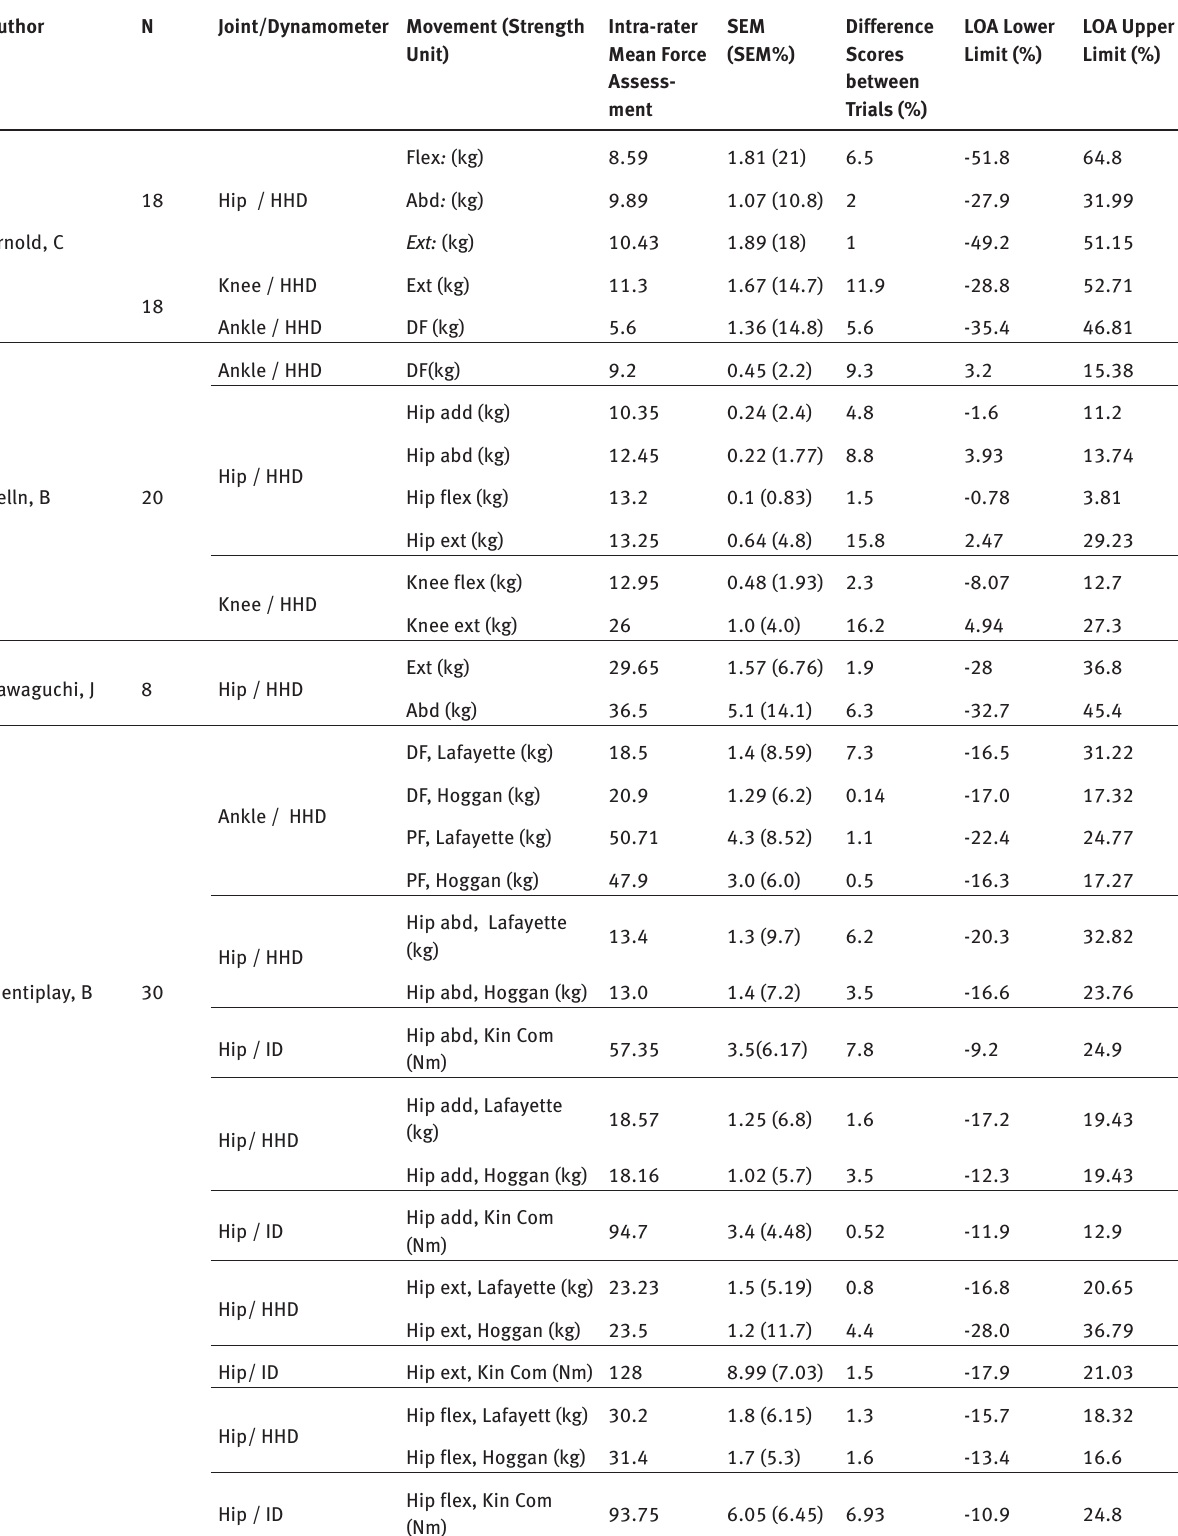
Table 2: Outcome studies analyzing absolute reliability of hhd and